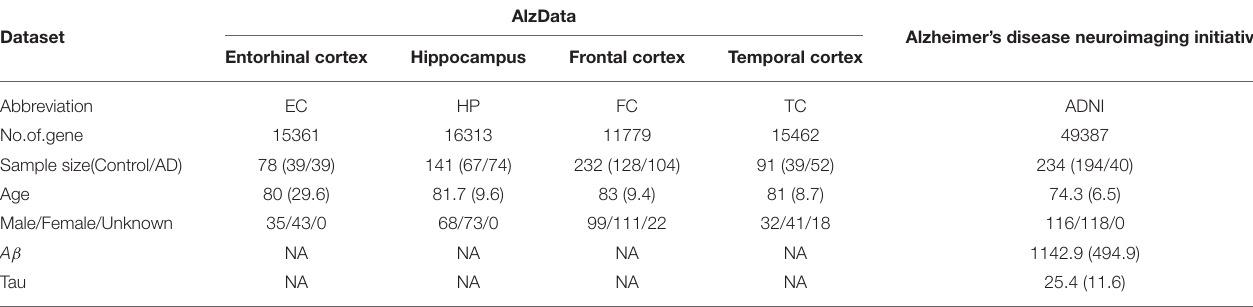
TABLE 1 | Brief descriptions for five datasets.